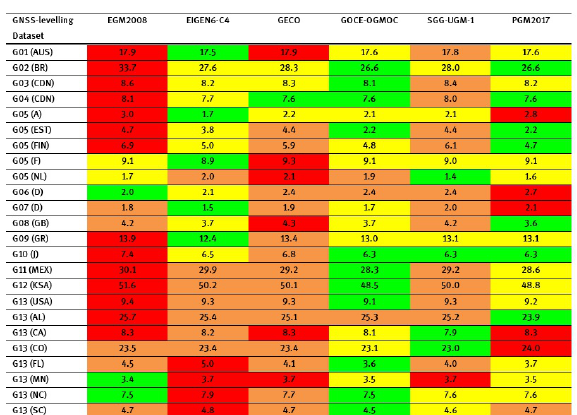
Table 3. RMS of geoid differences per regional data set in [cm]. Global models are computed with full resolution. A planar correc- tion surface is applied for each combination. First column: Region and country code (refer to Table 2). For G05, subsets for some Eu- ropean countries (see country code) and for G13, subsets for some US states (see state code) are considered. The colour code indicates the ranking per data set: Green = best, Yellow = closer to best; Or- ange = closer to worst; Red =